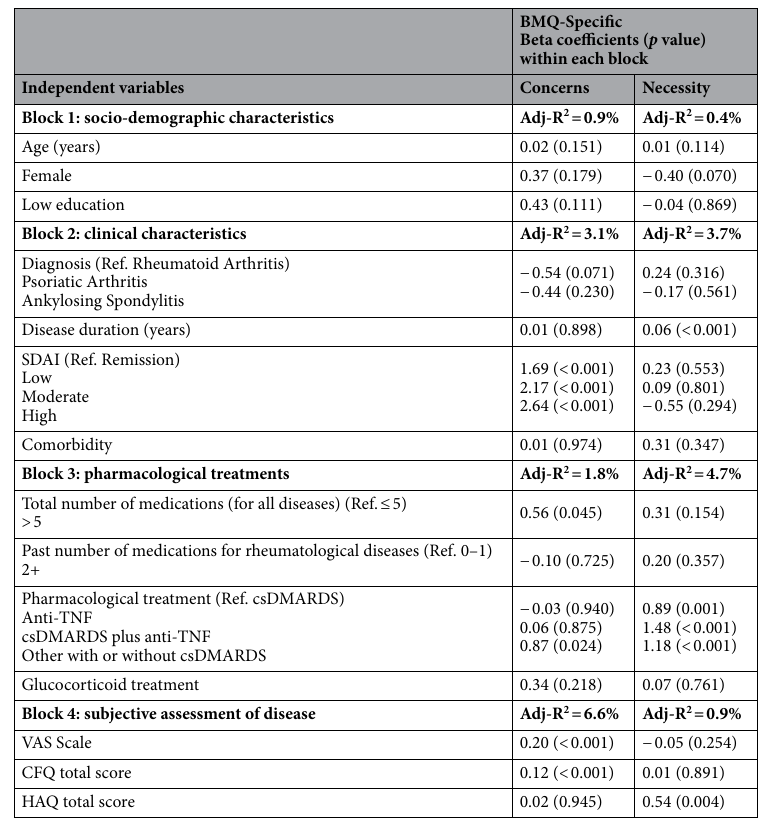
Table 3. Linear regression models for BMQ-Specific dimensions: Beta coefficients ( p value) within each block (n = 712).